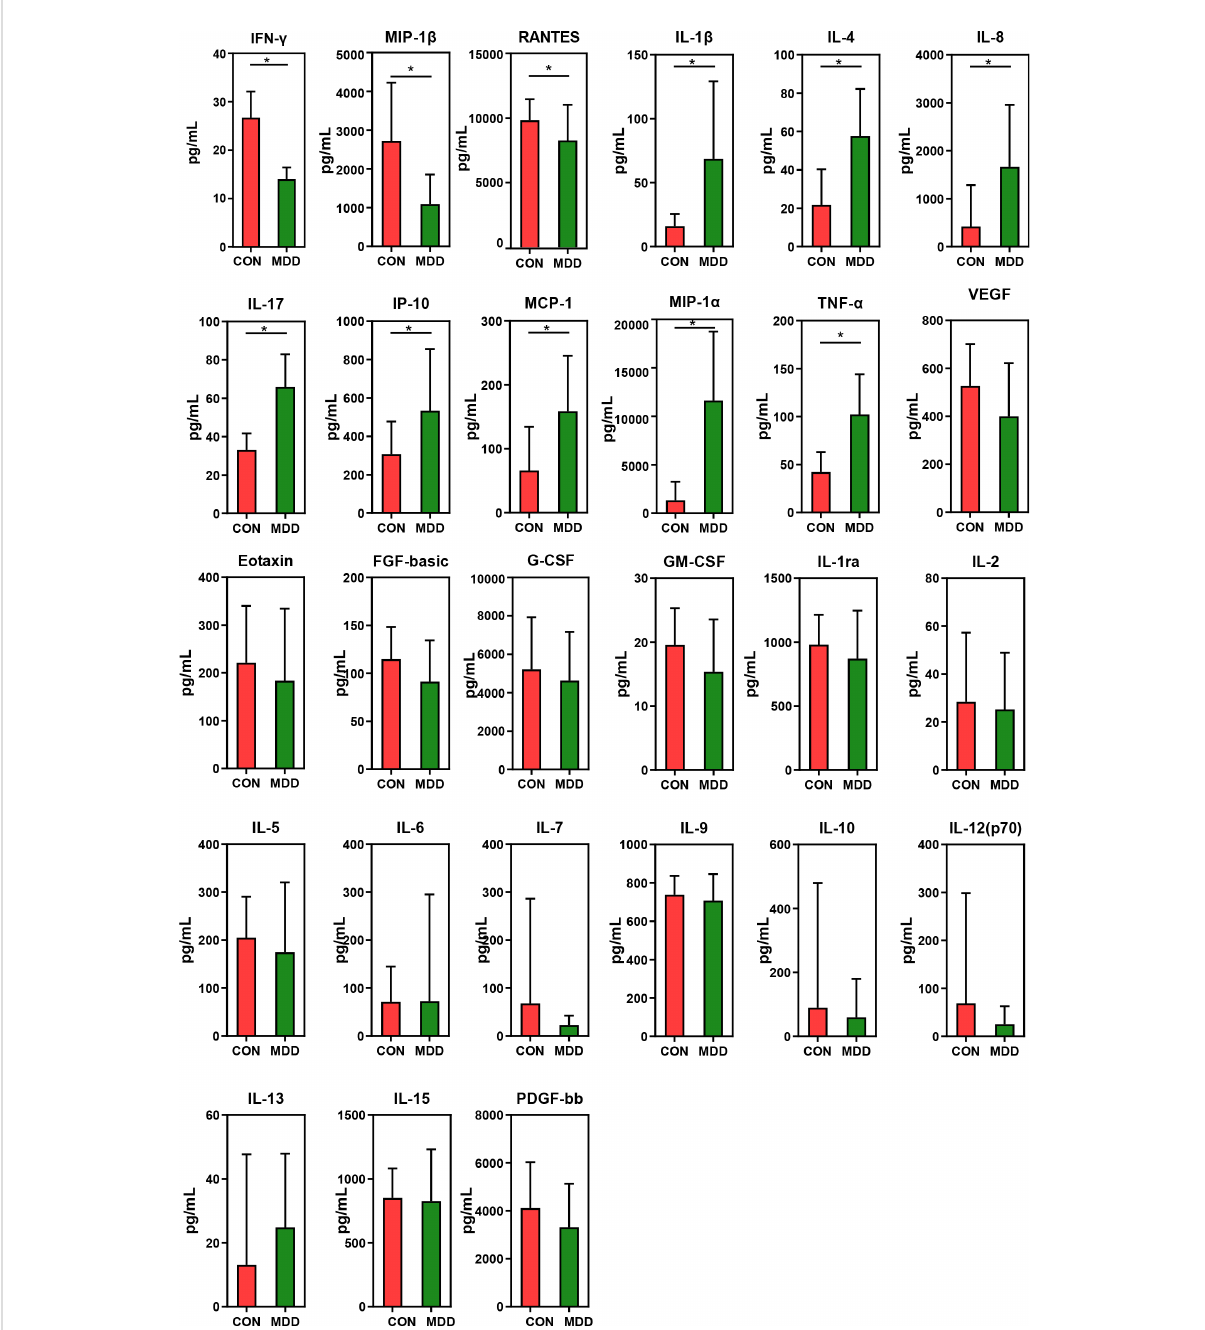
FIGURE 7 Mean (SEM) concentrations (pg/ml) of 27 pro- and anti-in fl ammatory cytokines and chemokines in childhood MDD patients and in healthy controls determined using Bio-Plex immunoassays. The concentrations of IL-1 b , IL-4, IL-8, IL-17, IP-10, MCP-1, MIP-1 a and TNF- a increased signi fi cantly in childhood MDD patients, while those of IFN- g , MIP-1 b and RANTES decreased signi fi cantly. *p <